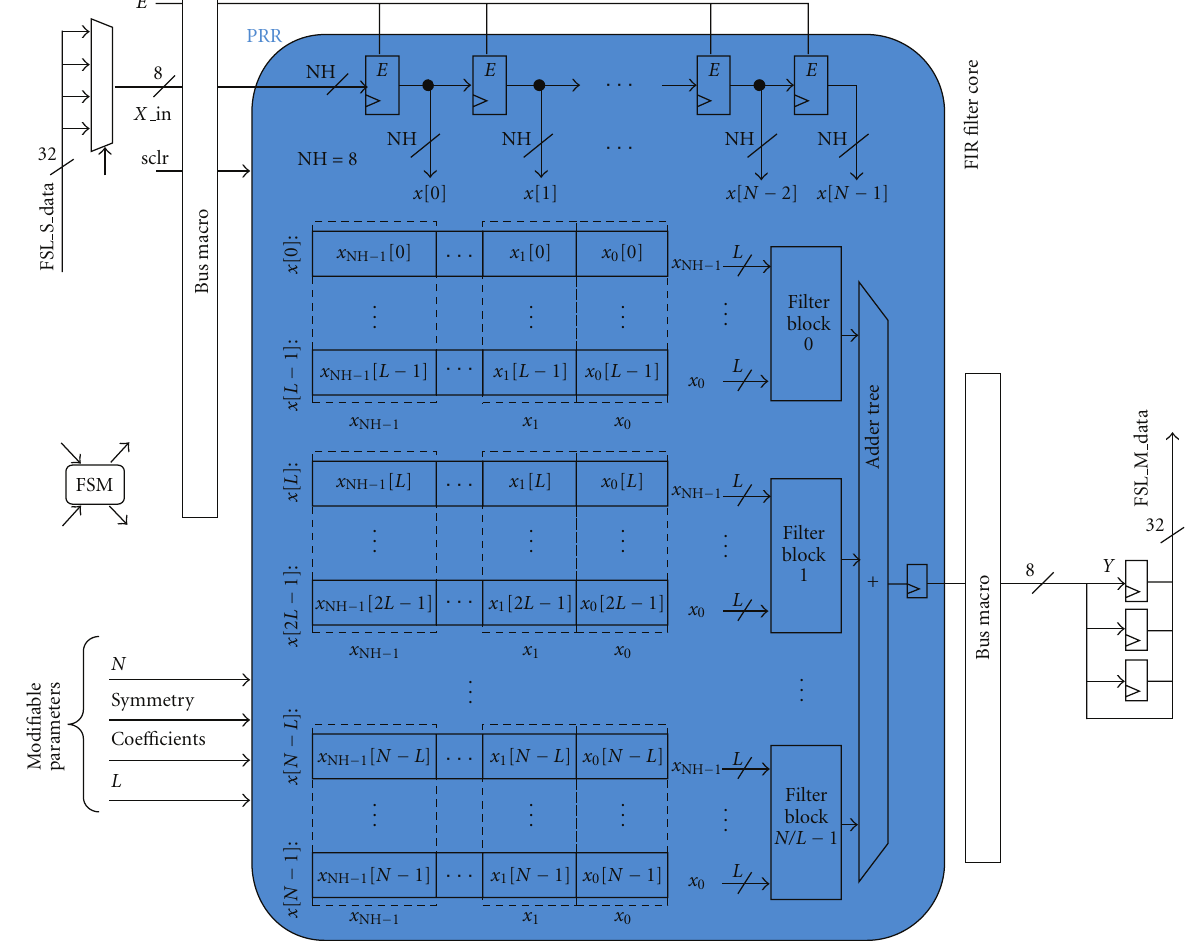
Figure 10: FIR filter processor where the PRR is the FIR Filter core. Note the parameters we can